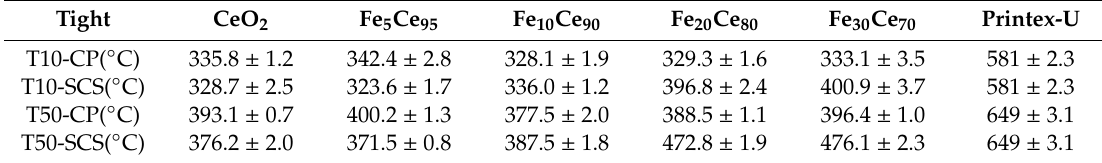
Table 3. T10 and T50 for catalysts in tight contact